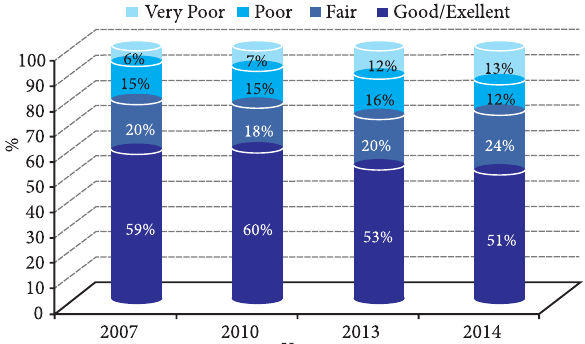
Fig. 1. Pavement condition of the main roads